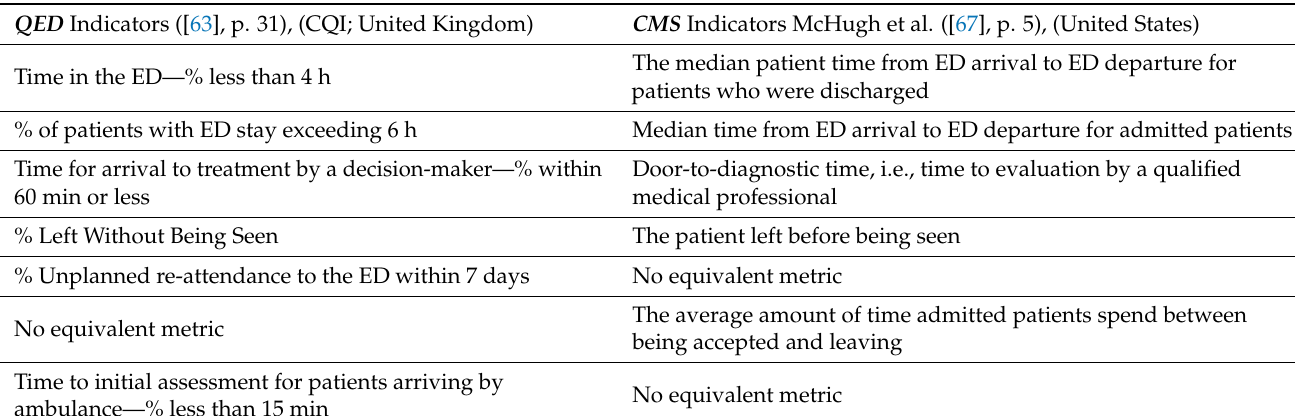
Table 4. Summary of Key ED Performance Indicators.